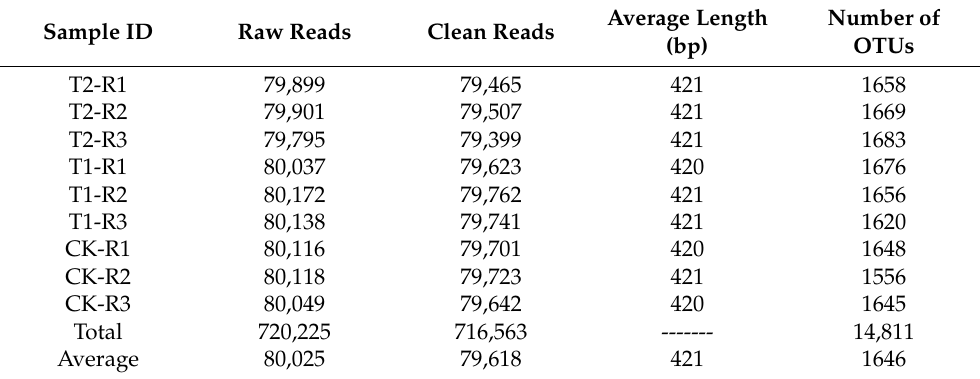
Table 2. High throughput sequencing data through amplification of the V3-V4 variable region of 16S rRNA.